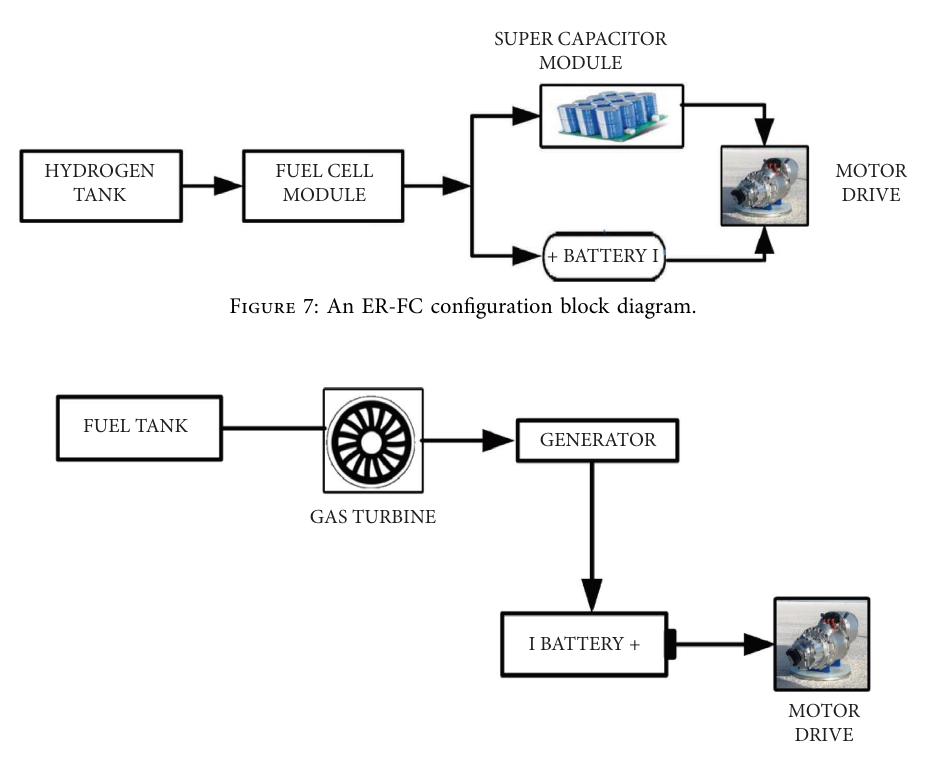
Figure 8: An ER-MGT confguration block